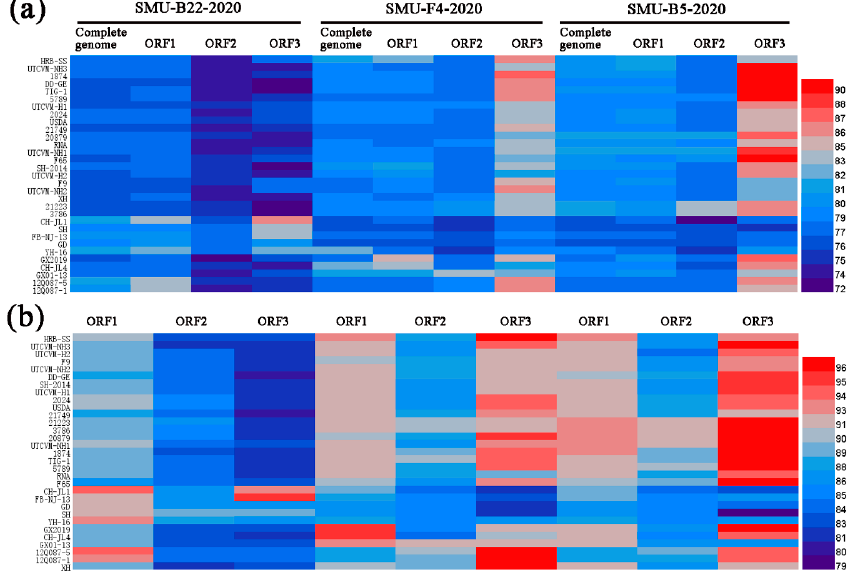
Figure 3. A heatmap was constructed based on the nucleotide sequence ( a ) and amino acid identities ( b ) of each genome among different FCV strains using HemI software. The colors represent sequence identity (blue for lower identities and red for higher identities) among different strains. The bar on the right represents the hierarchical similarity among the 15 meta-clusters (metric, Euclidean distance; linkage, average). Viruses 2021 , 13 , 1812